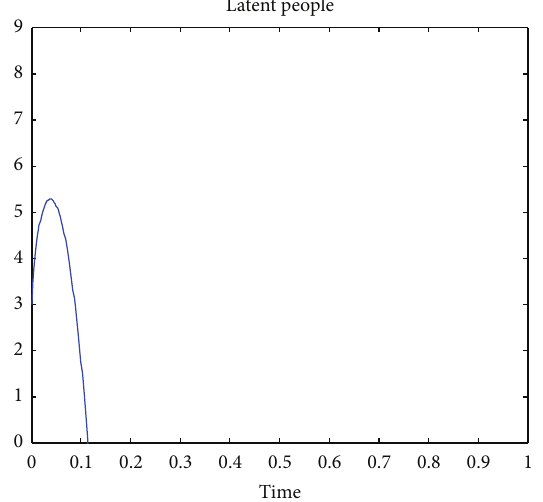
Figure 7: Approximate for 𝜇 = 0.045 , 𝜂 = 0.5 , and 𝜐 = 0.085 .